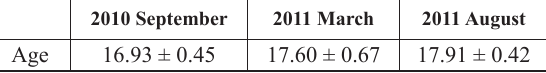
Table 2. Participant’s age in different playing periods